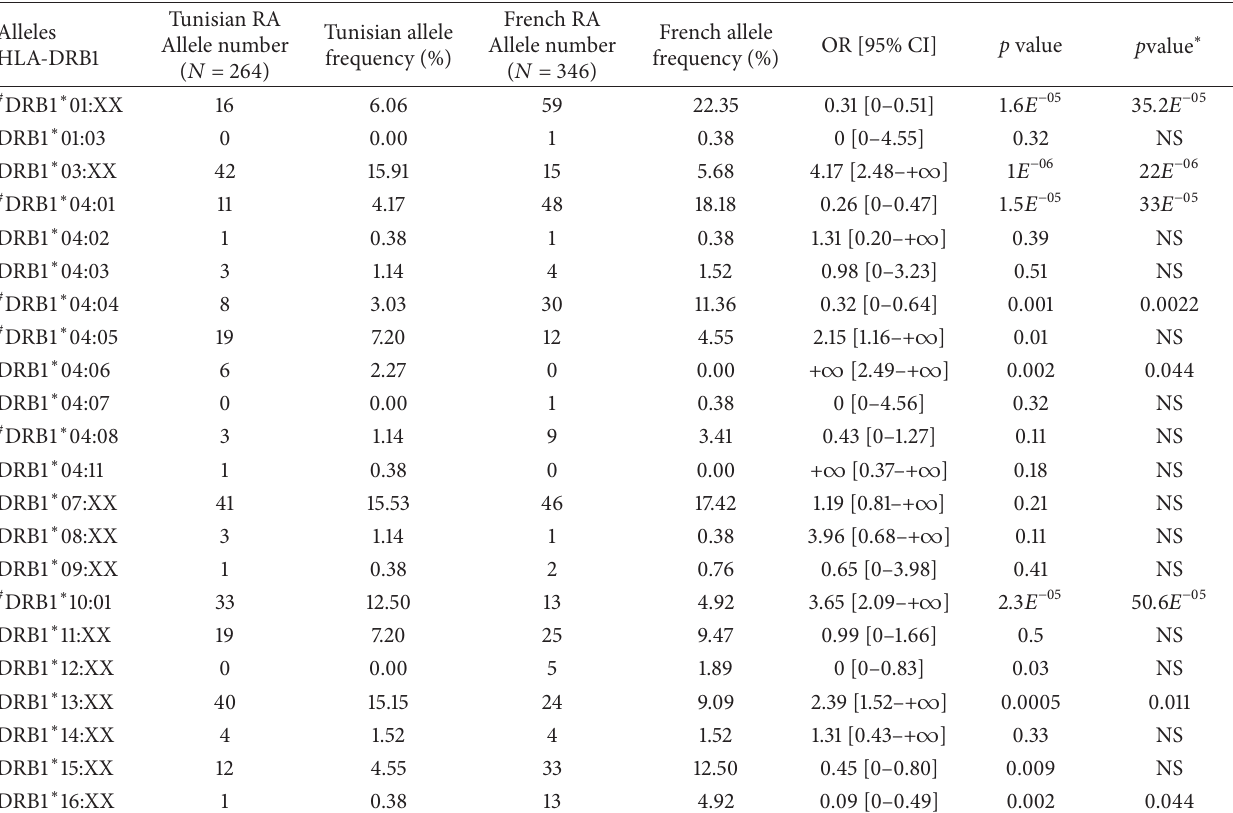
Table 2: Shared epitope frequency and HLA-DRB1 alleles frequency in Tunisian and French